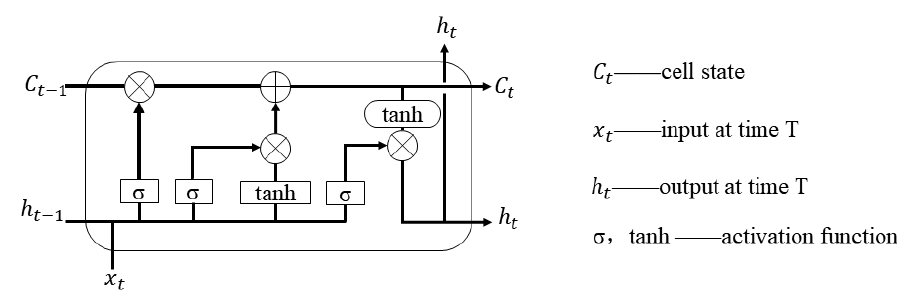
Figure 4. LSTM unit structure [28].